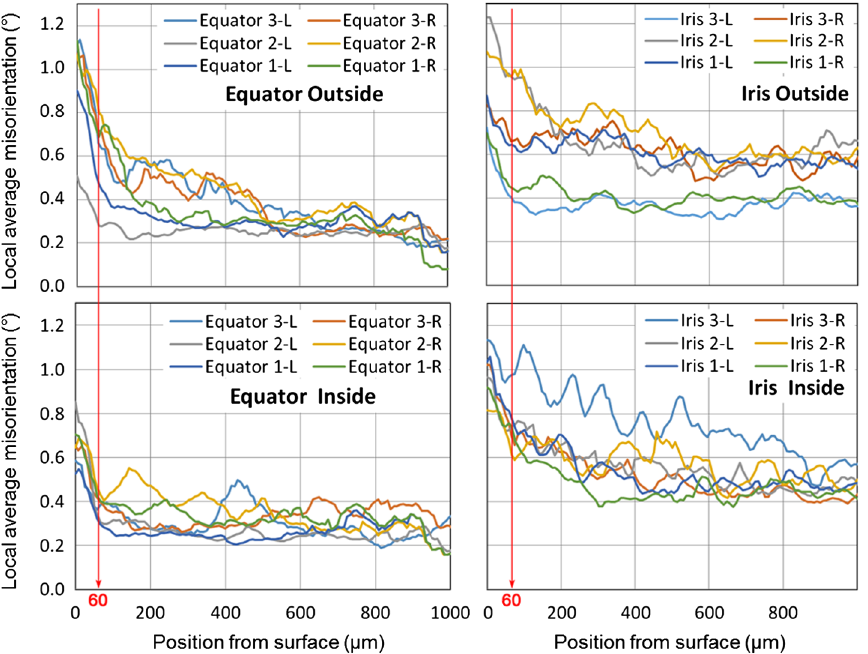
FIG. 9. Local average misorientation (LAM) profiles in the six grains obtained from averaged traces on the inside and outside of the equator and the